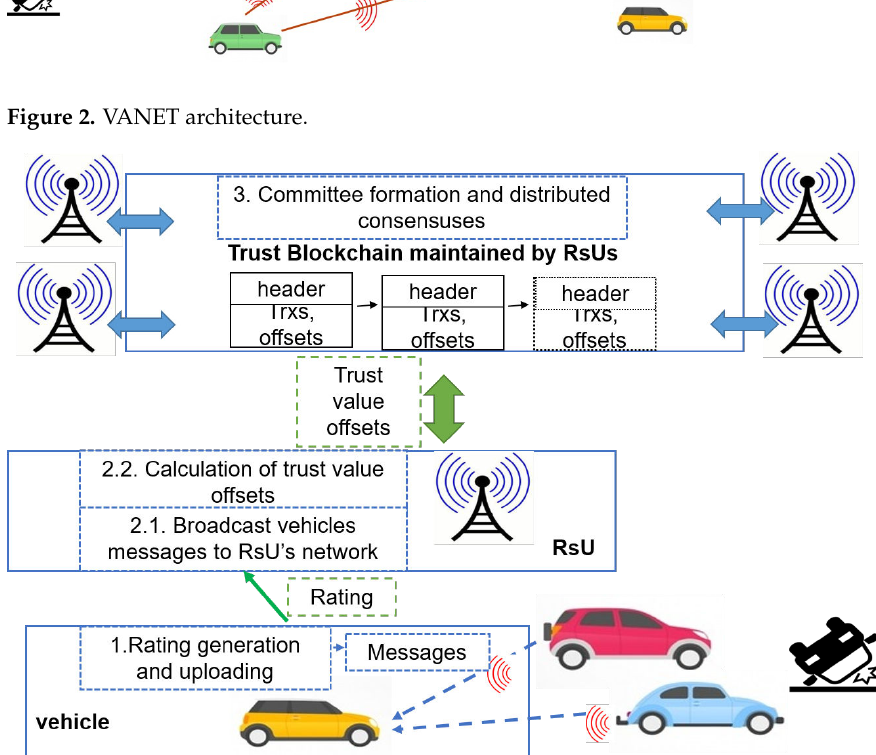
Figure 3. The proposed architecture: merging VANET with